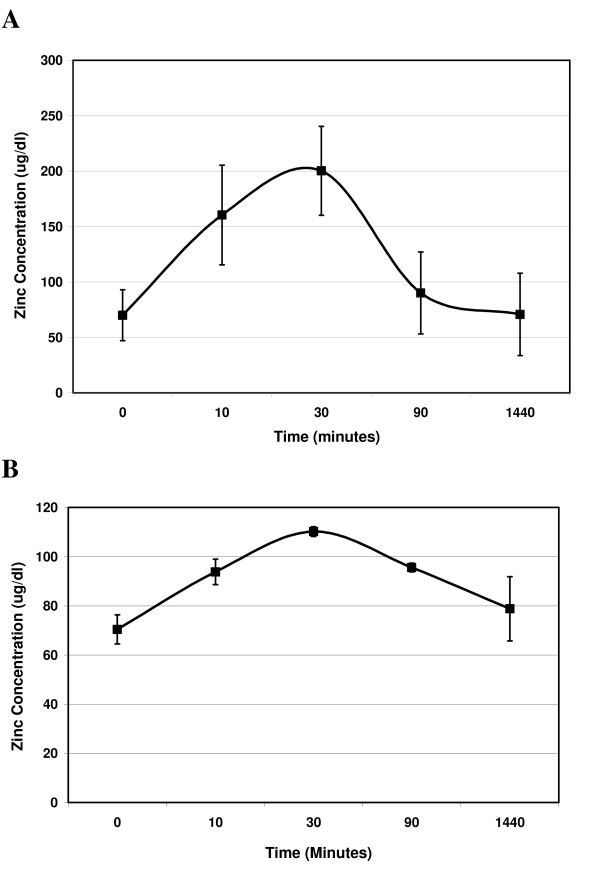
Serum Zinc Levels after Subcutaneous or Intratumoral Zinc Injection. Serum levels were measured at the indicated times following either a subcutaneous (A) or an intratumoral (B) single 200 μL injection of 3 mM zinc acetate. Data is presented as an average and errors bars indicate the standard deviation of four mice (n = 4).